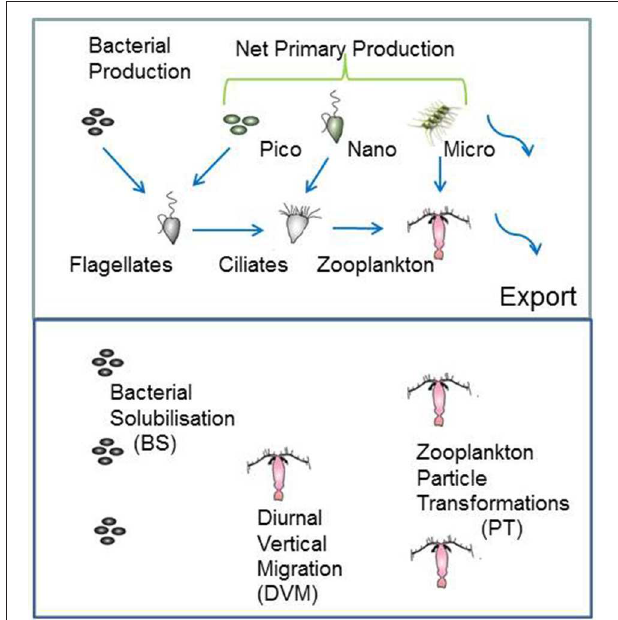
FIGURE 1 | Schematic of the coupled surface-subsurface model. The upper panel represents the euphotic zone (Ez) and the input of column-integrated net primary (NPP) and heterotrophic bacterial production (BP) to fuel downward POC export flux. NPP is partitioned between pico-, nano-, and micro-phytoplankton. Blue arrows show the grazing pathways the BP and NPP are routed through. Curved arrows denote the two pathways for POC to be exported from the Ez, direct sinking of a proportion of micro-phytoplankton NPP, and of mesozooplankton fecal pellets. For simplicity, pathways, such as bacterivory by ciliates (see Bernard and Rassoulzadegan, 1990) are not included. The lower panel denotes subsurface waters from the base of the Ez to 500m depth, where attached microbes continuously solubilise POC, vertical migrators daily shunt POC to depth, and mesozooplankton transform particles via